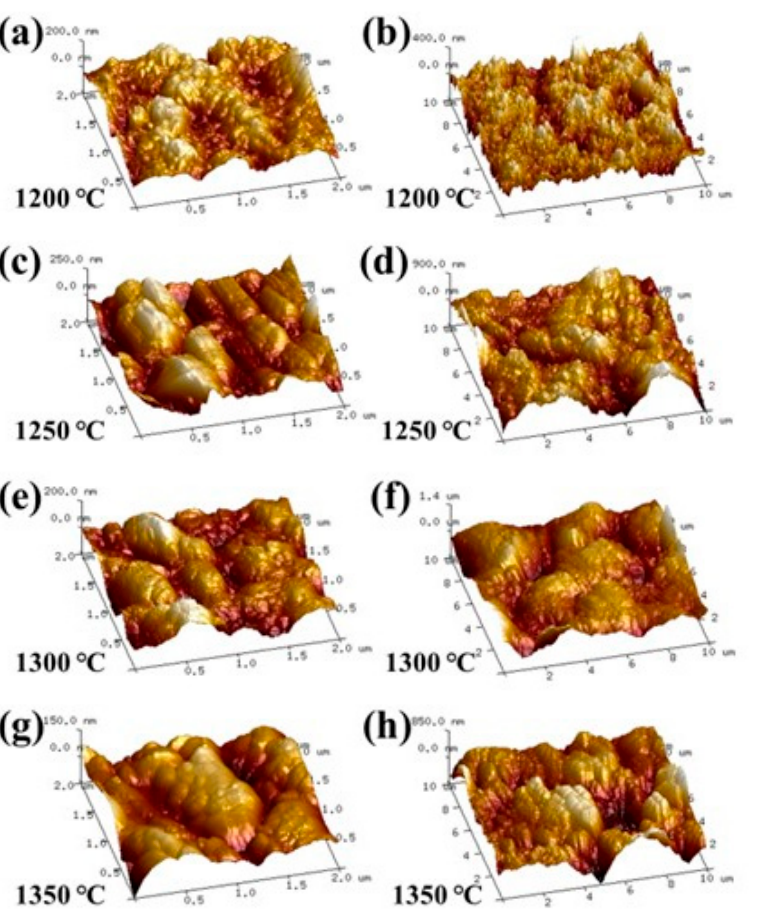
Figure 6. AFM images of HfO 2 coatings prepared at different deposition temperatures. ( a ) 1200 °C; ( b ) 1200 °C; ( c ) 1250 °C; ( d ) 1250 °C; ( e ) 1300 °C; ( f ) 1300 °C; ( g ) 1350 °C; ( h ) 1350 °C.